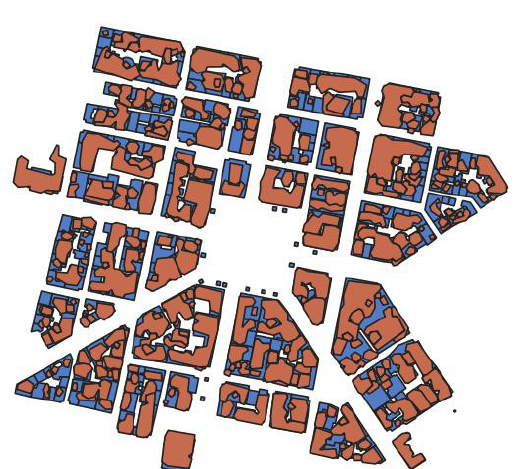
Figure 14: Openstreetmap polygons (blue) compared to the detected polygons